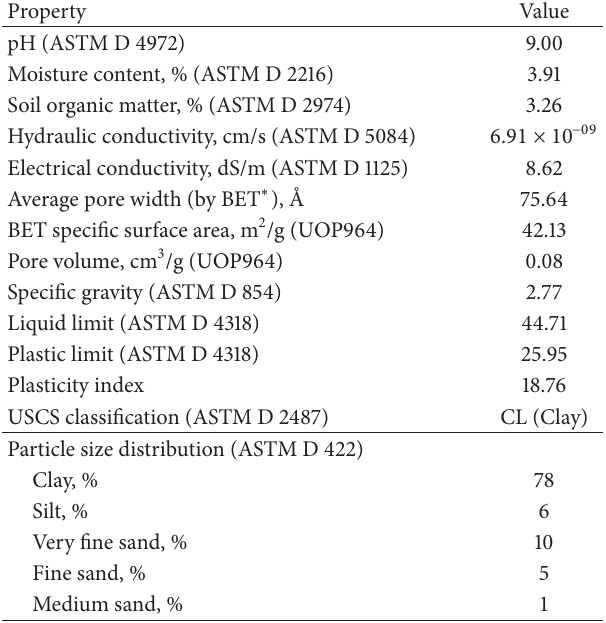
Table 1: Physicochemical properties of saline-sodic soil [24].